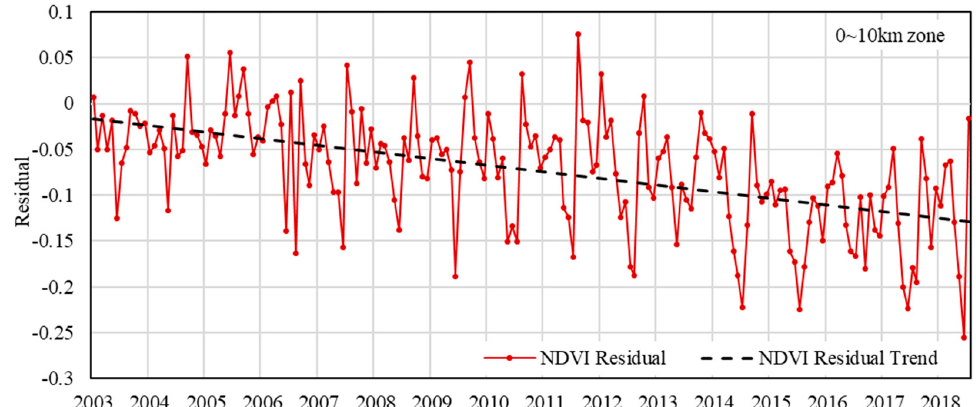
Figure 8. NDVI residuals and residual trend after water impoundment.